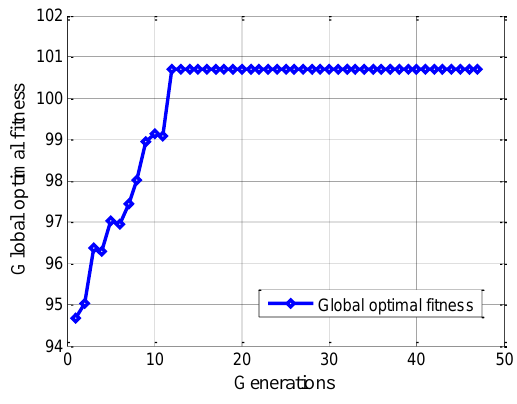
Figure 3. Trend of global optimal fitness.